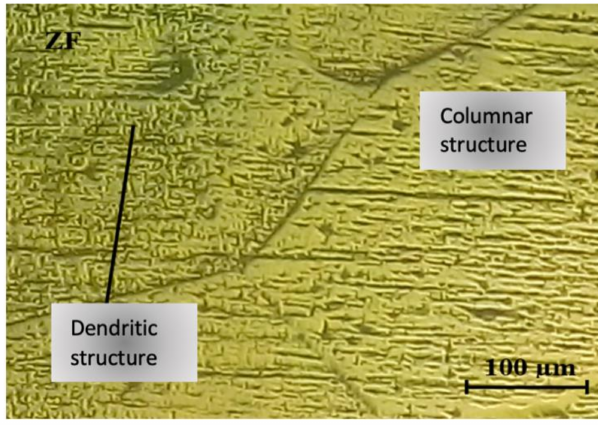
Figure 4. Welded metal zone micrography.